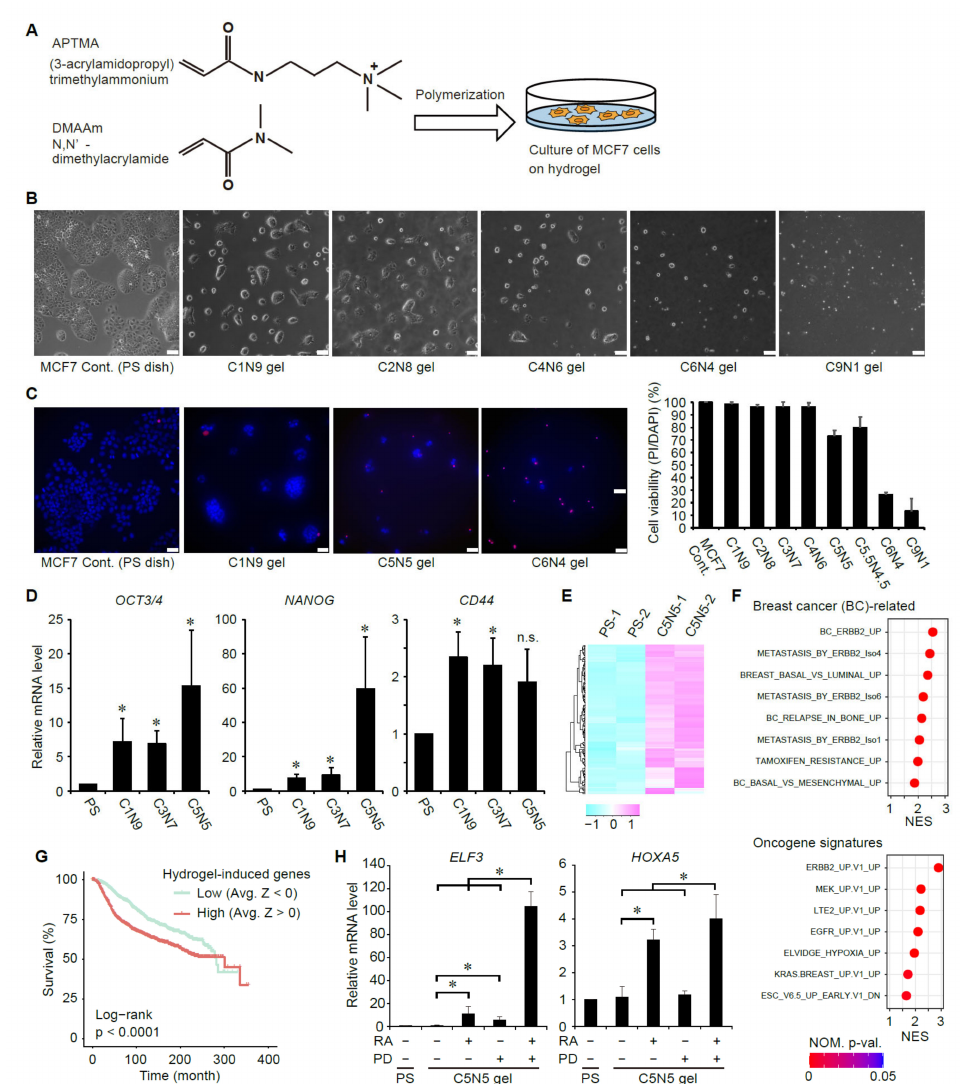
Figure 4. ERK inhibition promotes ligand-dependent RAR-target gene expression in MCF7 cells expressing high levels of CSC markers. ( A ) Schematic representation of the synthesis of the poly(DMAAm-co-APTMA) hydrogel and its use in cell culture. ( B ) Morphology of MCF7 cells cultured on the hydrogels with varying ratios of APTMA to DMAAm. ( C ) Survival rates of MCF7 cells cultured on the poly(DMAAm-co-APTMA) gels. Dead cell nuclei were stained by propidium iodide (PI). ( D ) Expression levels of CSC markers in MCF7 cells cultured on the poly(DMAAm- co-APTMA) gels for 3 days were analyzed by qRT-PCR. *, p < 0.05 (one-way ANOVA followed by Tukey post hoc analyses) (mean + s.d., n = 3). ( E ) A heatmap showing normalized expression values ( Z -scores) of genes induced by the C5N5 hydrogel. The data were derived from RNA-sequencing analyses of MCF7 cells cultured on PS dishes or the C5N5 hydrogel. ( F ) Gene sets significantly upregulated in MCF-7 cells cultured on the C5N5 hydrogel. NES: normalized enrichment